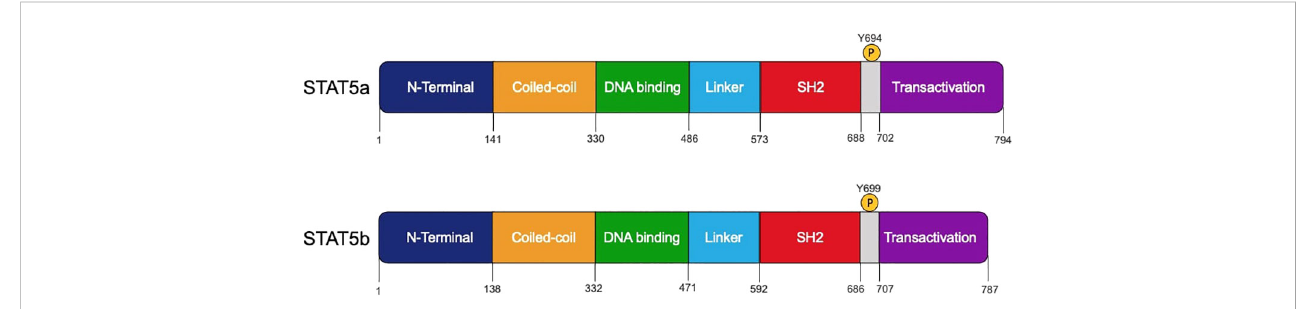
FIGURE 1 Schematic structures of human STAT5a and STAT5b protein domains. The domains, amino acids residue positions, and the tyrosine 694 and 699 that can be phosphorylated by JAK proteins are